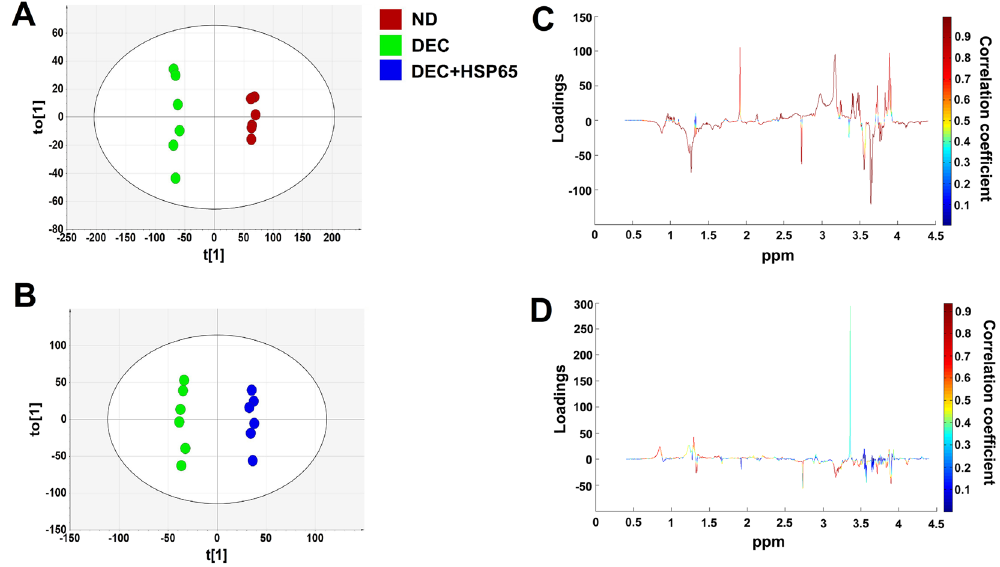
Figure 2. Chemometric analysis of decidualized hESC treated with and without HSP65 and non-decidualized cells. Two dimensional scatter score plot of OPLS-DA of ND vs DEC ( A ), OPLS-DA of DEC vs DEC + HSP65 ( B ). The coefficient loading plots of OPLS-DA models (ND vs DEC ( C ); DEC vs DEC + HSP65 ( D )) is represented as color maps (MATLAB R2009a, The MathWorks, Inc., USA). The color bar is indicating the modulus of